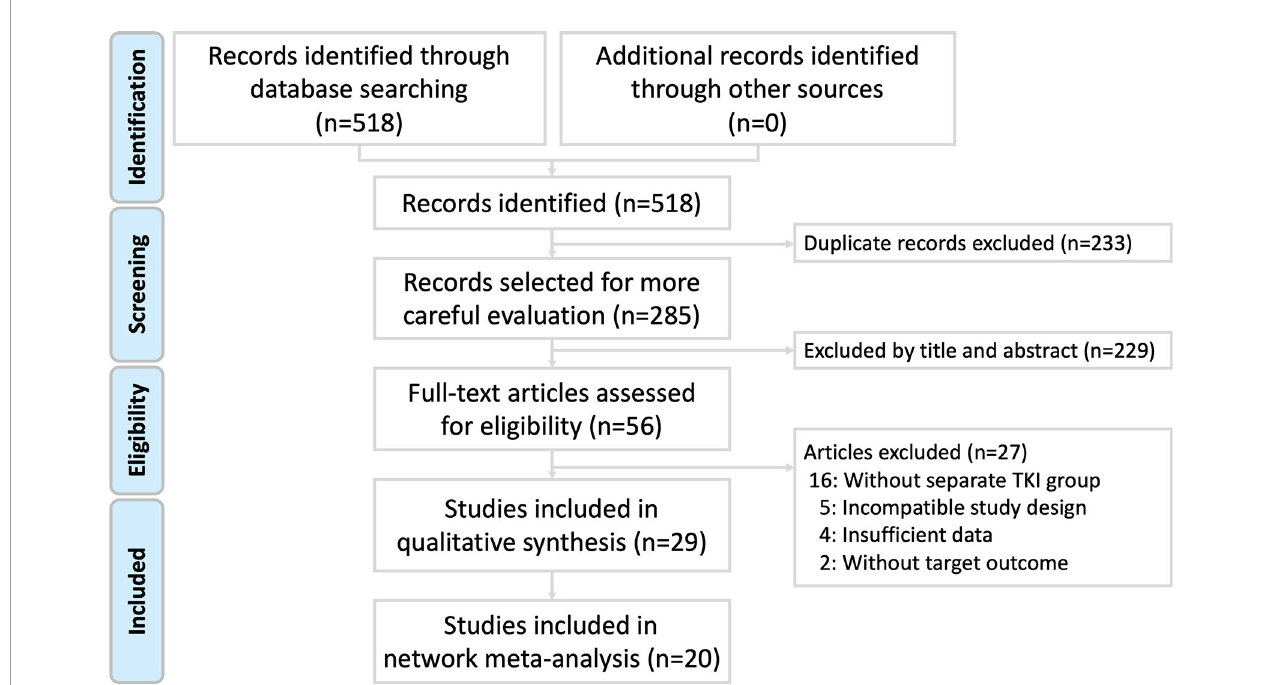
FIGURE 1 | Study fl ow